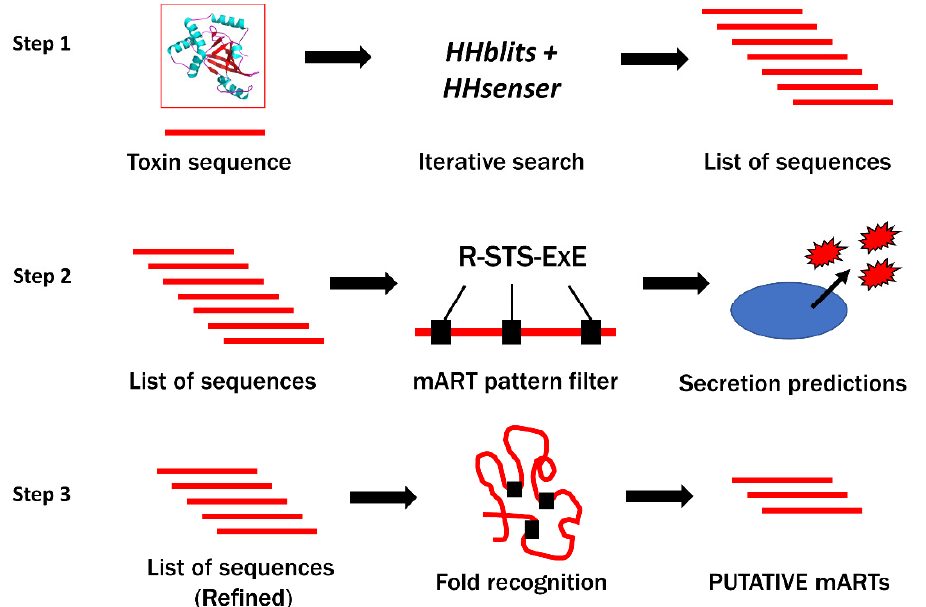
Figure 1. Summary of mART toxin discovery pipeline. Step 1: Known mART toxin sequences are used (input) to provide several thousands (10,000–20,000) of candidate toxin sequences arising from iterative search tools such as HHblits and HHsenser. This mining strategy is analogous to a large-scale BLAST search that cater to protein homologs with low sequence identity [32,33]. Step